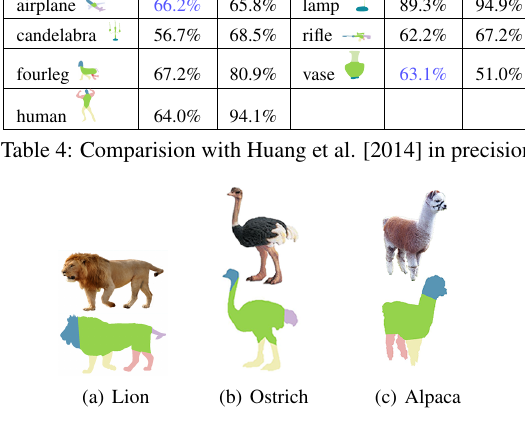
Figure 8: Semantic segmentation of three new shapes (without prior indexing of these classes by